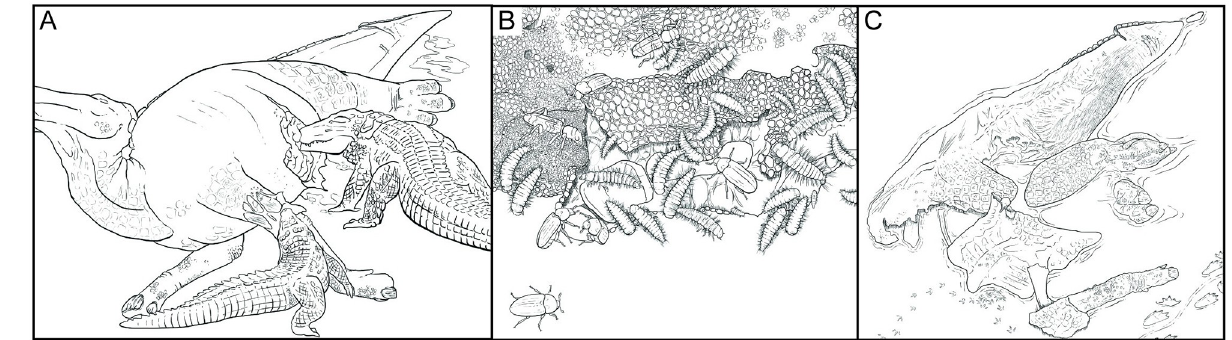
Fig 10. Proposed soft tissue preservational pathway based on examination of NDGS 2000 ( Edmontosaurus sp.). (A) Incomplete predation and/or scavenging of the carcass creates openings in the body wall through which fluids and gasses can escape. (B) Invertebrates and microbes use those openings to access the internal tissues. (C) Removal of internal soft tissues and drainage of fluids and gasses associated with decomposition allows the deflated skin and other dermal tissues to desiccate and drape over the underlying bones. This process facilitates longer-term persistence of the skin and other resistant soft tissues until eventual burial and fossilization. Paleoart by Becky